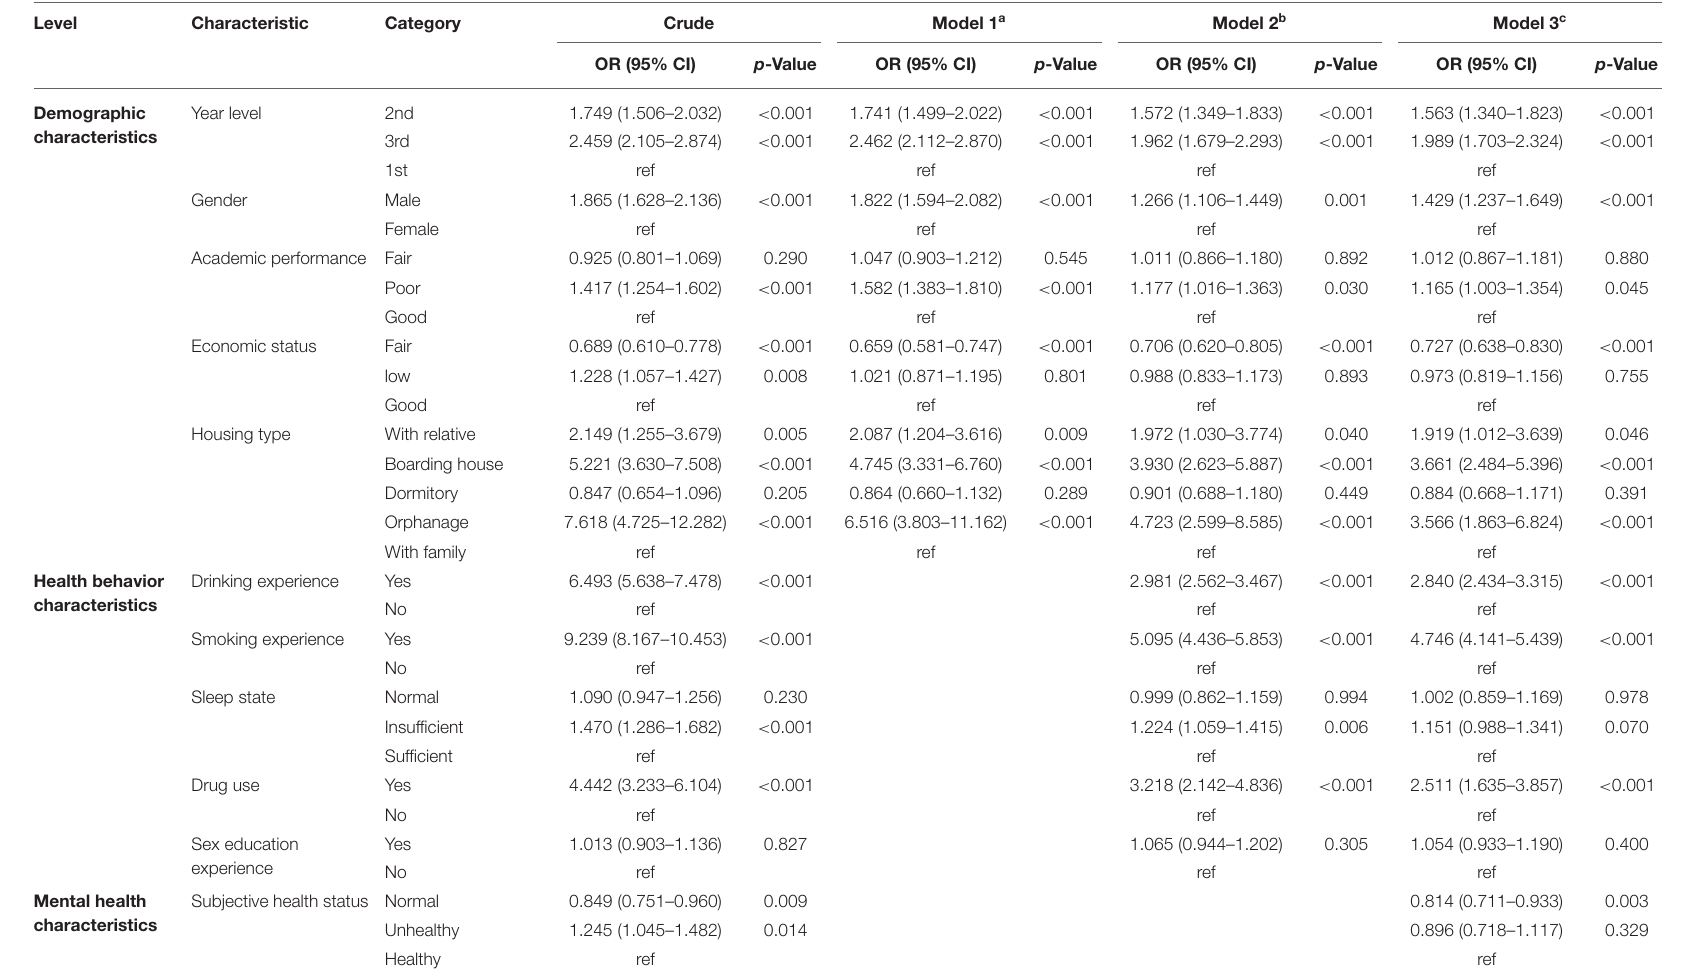
TABLE 5 | Factors affecting sexual intercourse in high school students ( n =